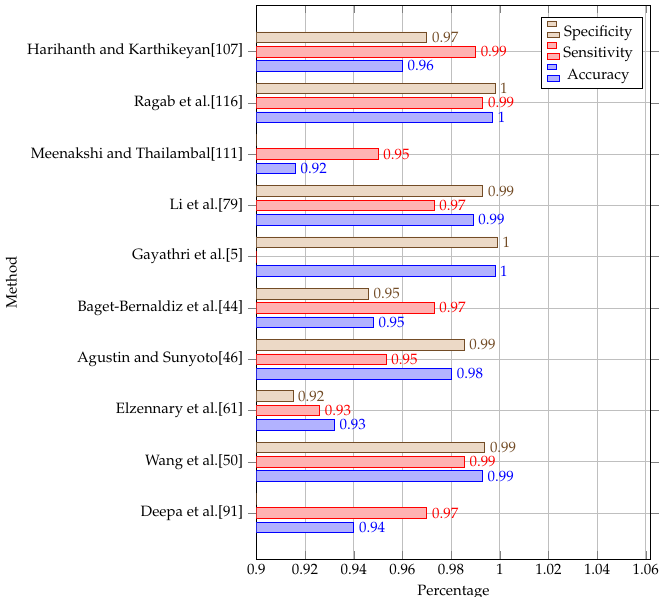
Figure 6. Performance Comparison of Diabetic Retinopathy grading-based studies that used the MESSIDOR dataset MESSIDOR a challenging task even due to the improvement reached during the last ten years using 430 different deep learning techniques. 431